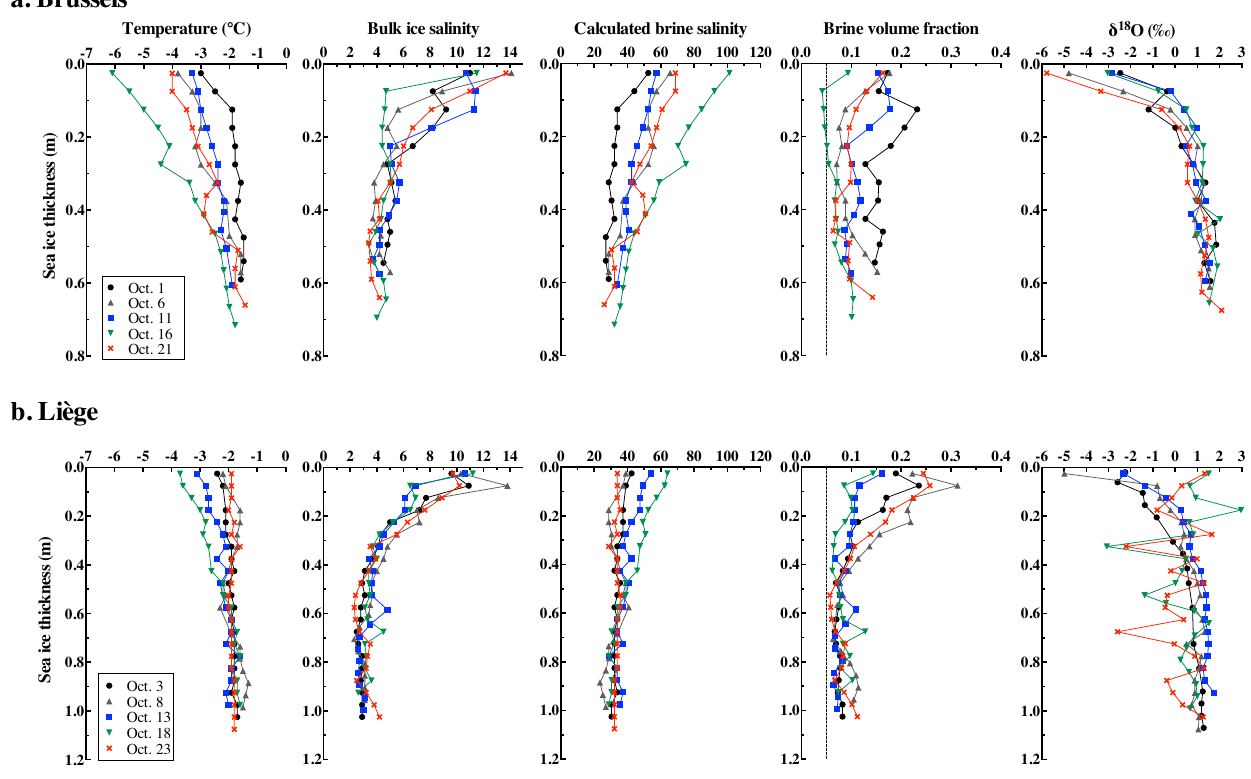
Figure 4. Profiles of temperature ( ◦ C), bulk ice salinity, calculated brine salinity, brine volume fraction, and 18 O isotopic ratio from the Brussels (top panels) and Liège (bottom panels)